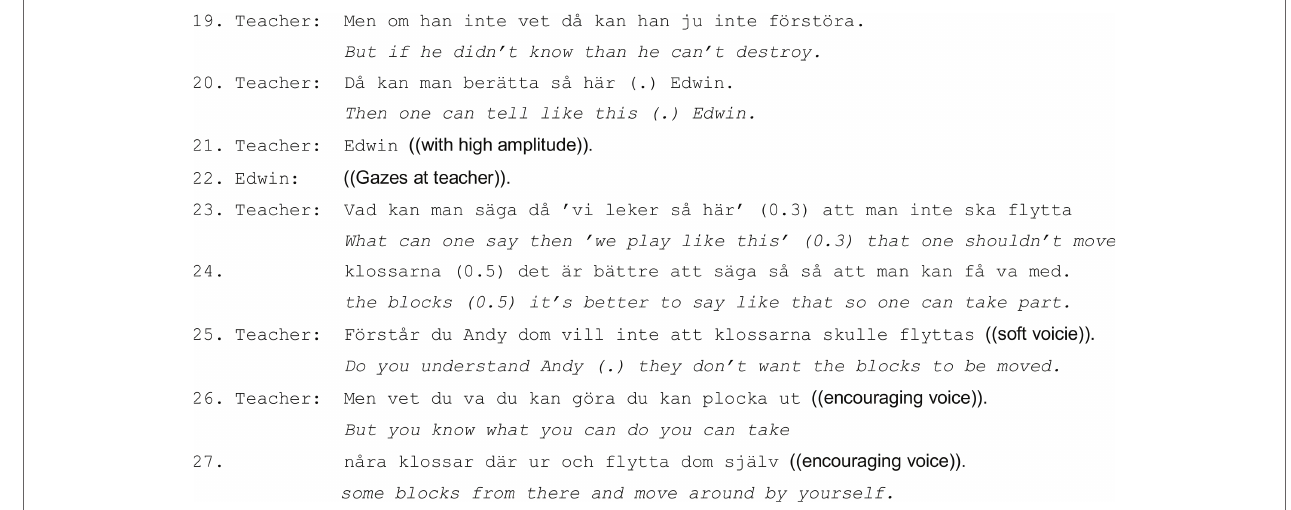
FIGURE 4 | Excerpt